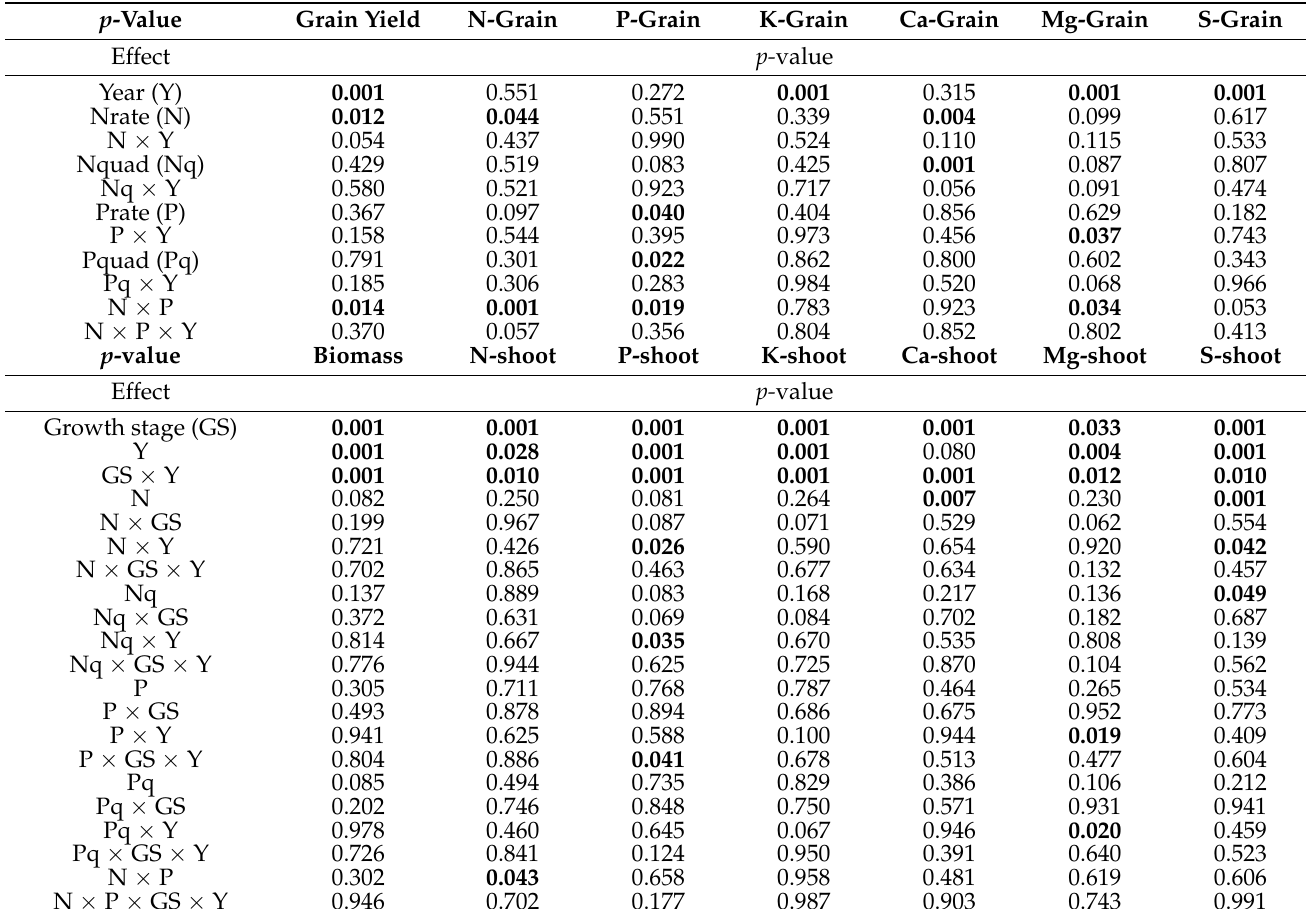
Table A2. Summary of statistical analysis for grain yield; grain N, P, K, Ca, Mg, and S accumulation; biomass accumulation; biomass N, P, K, Ca, Mg, and S accumulation under incorporated residue management in 2013 and 2014 as a function of year, growth stage, and N and P 2 O 5 application